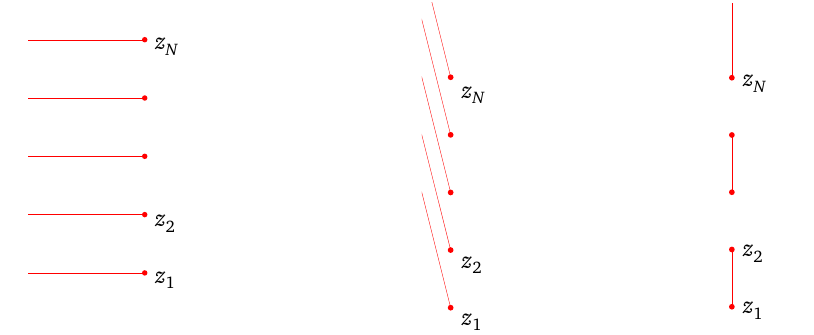
Figure 4: Three different choices of branch cuts (solid lines) for the function h + defined in (27) with N = 5. The branch points z function h + is multiplied by − 1 after crossing any branch